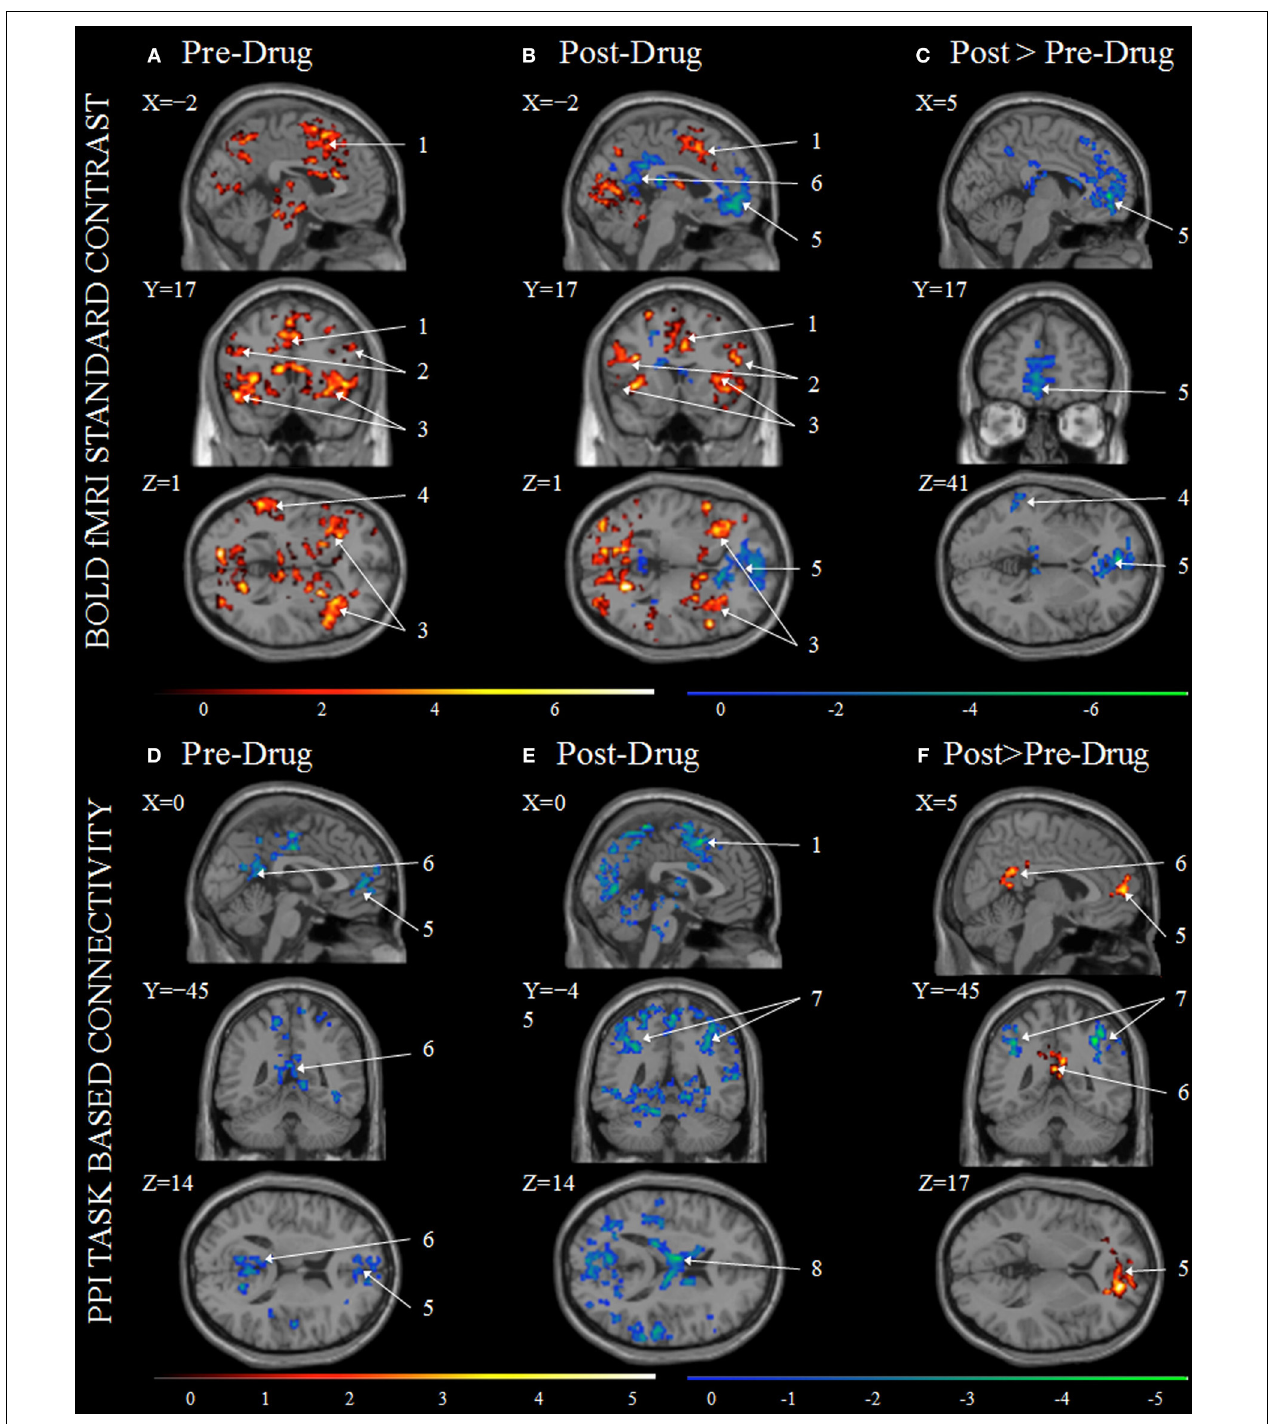
FIGURE 2 | Stroop task BOLD contrasts and Psychophysiological Interaction (PPI) analysis results. Group BOLD activation (red) and deactivation (blue) maps shown for BOLD at baseline scans pre-drug (A) , BOLD for week 12 scan post-drug (B) , and BOLD Post > Pre-drug (C) as well as PPI for baseline scan pre-drug (D) , PPI post-drug (E) , and PPI Post > Pre-drug (F) . All color intensities are voxel-wise t -statistics with